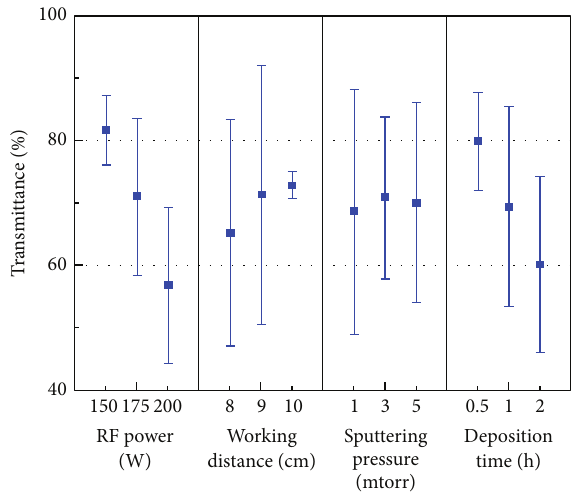
Figure 7: Response graph of the four factors versus transmittance. The ranking of the order of magnitude of transmittance for various levels indicates that the effects of various factors on the transmit- tance are ranked in the following order: RF power, deposition time, working distance, and sputtering pressure.